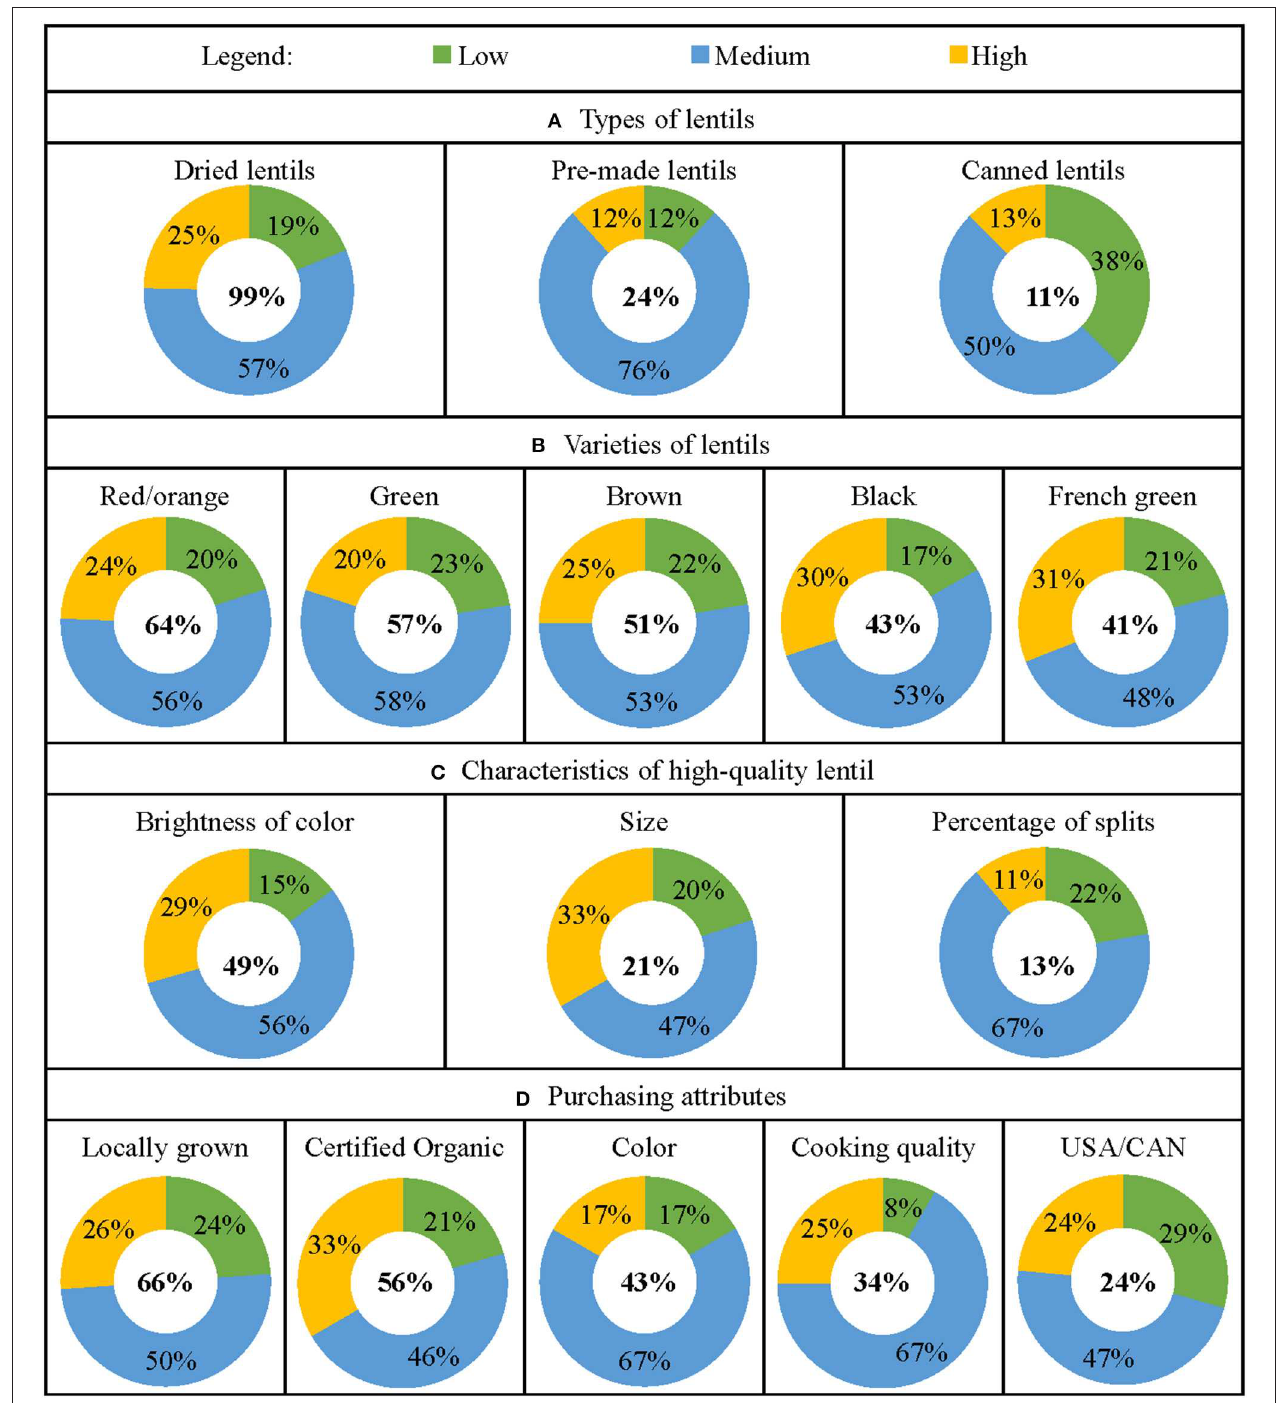
FIGURE 9 | Purchasing attributes and lentil characteristics. (A) Total percentage (center), and proportion of low, medium, and high lentil consumption groups that reported lentil characteristics that influence purchasing decisions based on lentil types including dried lentils, pre-made lentil meals, and canned lentils. (B) Total percentage (center), and proportion of low, medium, and high lentil consumption groups that reported lentil characteristics that influence purchasing decisions based on lentil varieties including red/orange, green, brown, black, and French green. (C) Total percentage (center), and proportion of low, medium, and high lentil consumption groups that reported characteristics that constitute a high-quality lentil including brightness of color, size, and percentage of splits. (D) Total percentage (center), and proportion of low, medium, and high lentil consumption groups that reported lentil attributes that influence purchasing decisions including locally grown or grown in Montana (USA), certified organic, color, cooking qualities, and grown in the United States or Canada ( n = 70).